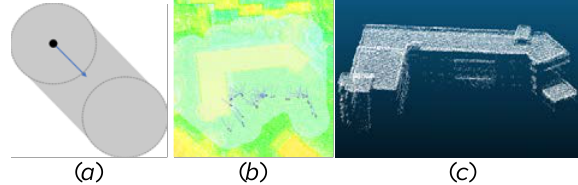
Figure 2. Extracting LiDAR building point clouds corresponding to ground image point cloud. (a) buffer zone of possible building LiDAR points from GPS position of a camera. (b) top view of elevation coloured LiDAR point cloud in the background. Grey translucent region around the target building (yellow region at the centre) shows the overlay buffer zones of all cameras. (c) extracted LiDAR building point cloud.